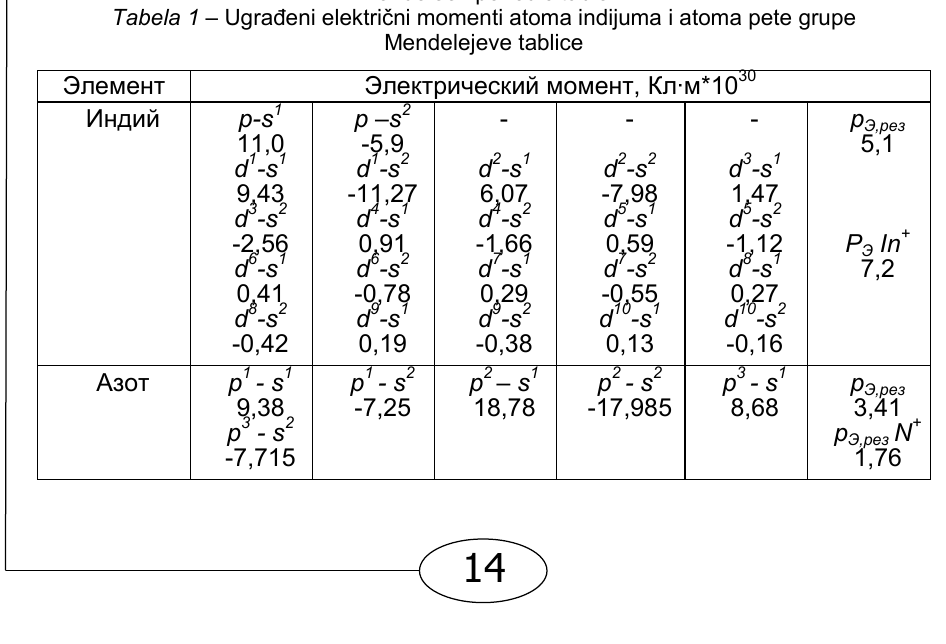
Table 1 – Incorporated electric moments of Indium atoms and the atoms of Group 5 of